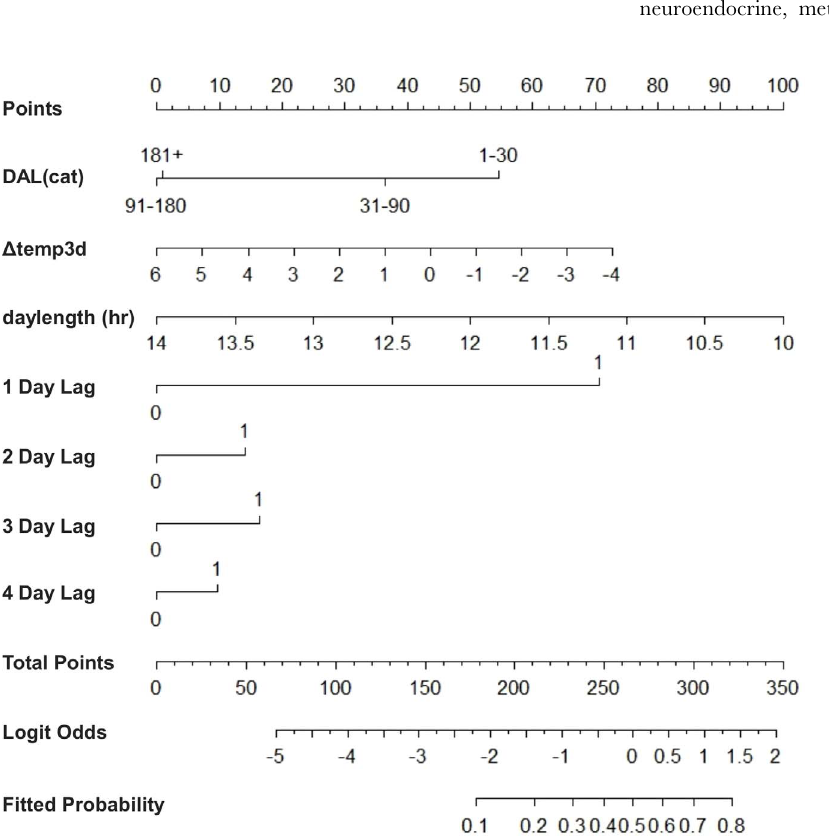
Figure 3. Nomogram depicting effect sizes for the best supported lemon shark residency model. To use the nomogram, locate the desired level of each variable and follow the position vertically up to the Points Scale. Repeat this for all variables and add up the points, then find that value on the Total Points Scale. Finally follow that position directly down to the Fitted Probability Scale which gives the predicted probability of daily detection.